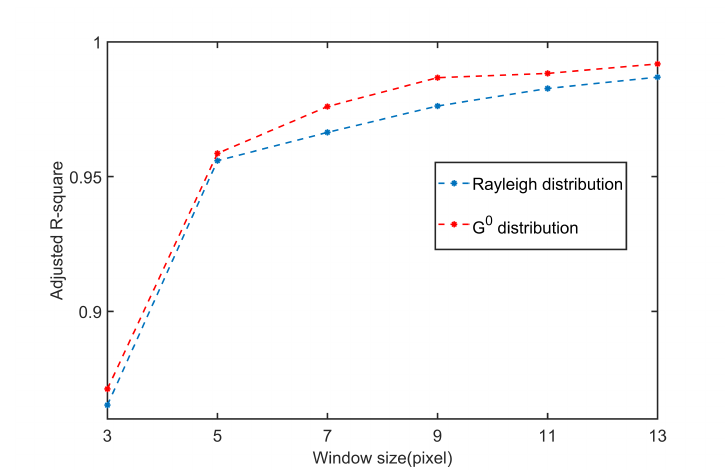
Figure 9. The relationship between the size of the sliding window and the goodness-of-fit.